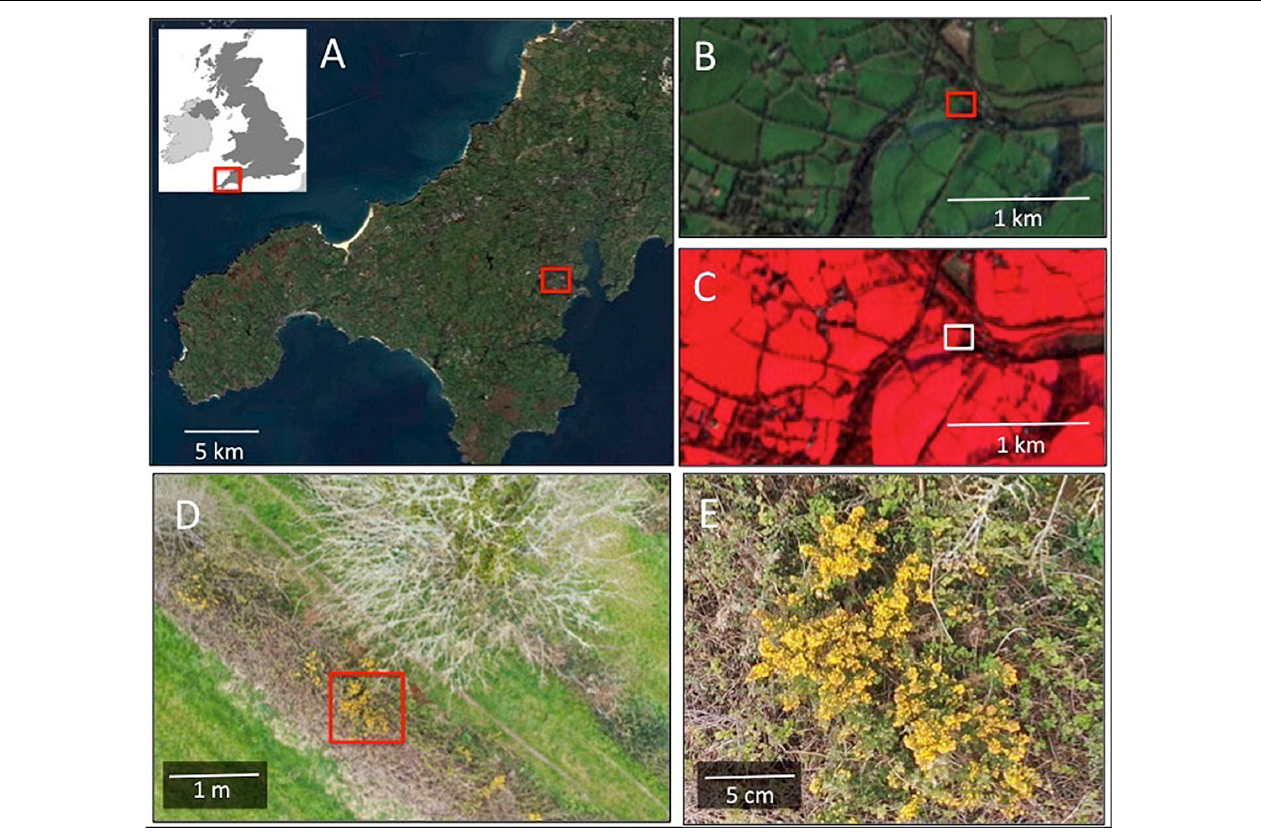
FIGURE 4 | Scale-varying views of flower-scapes from satellites to drones. (A) Shows a regional perspective imaged in optical (RGB) wavelengths from the Sentinel-2 satellite at 10 m spatial resolution. (B) Is a local perspective of the highlighted region in (A) , also at 10 m spatial resolution showing a neighborhood view comprising a mixed agricultural and residential area with various floristic resources including private gardens, woodlands and hedgerows. (C) Shows the same area as (B) but viewed using a false color composite (Bands 8, 4, 3). (D) Is a drone captured image from the region highlighted in (B,C) in optical wavelengths (RGB) acquired from a survey height of 25 m during spring budburst (April 2020). Gorse ( Ulex europaeus ; yellow) and blackthorn ( Prunus spinosa ; white) flowers can be seen in the hedgerow. The spatial resolution of this image is finer than 1 cm. (E) Is a highlight of the image shown in (D) , over the area highlighted showing in detail a bunch of gorse